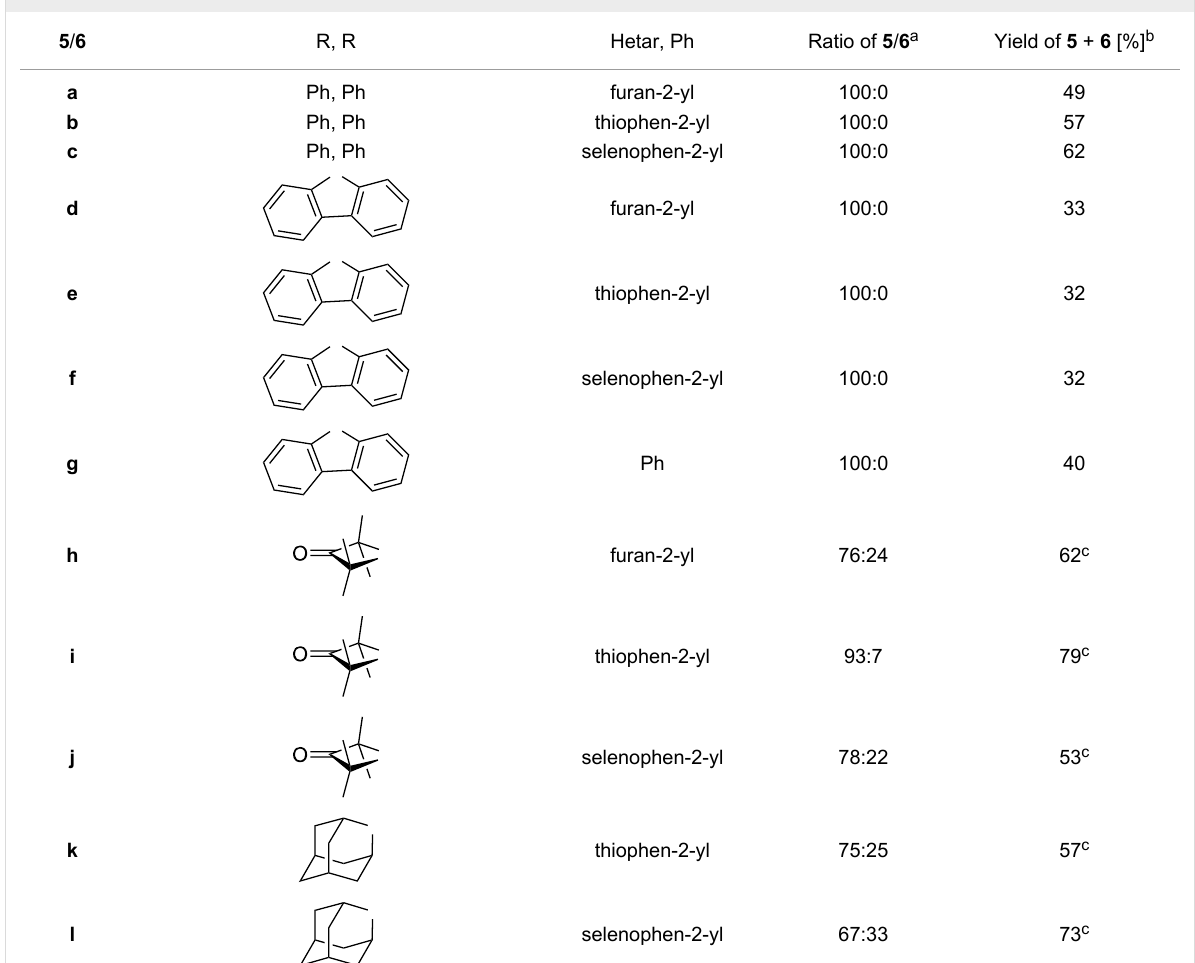
Table 1: Ferrocenyl-substituted 1,3-dithiolanes 5 and 6 .